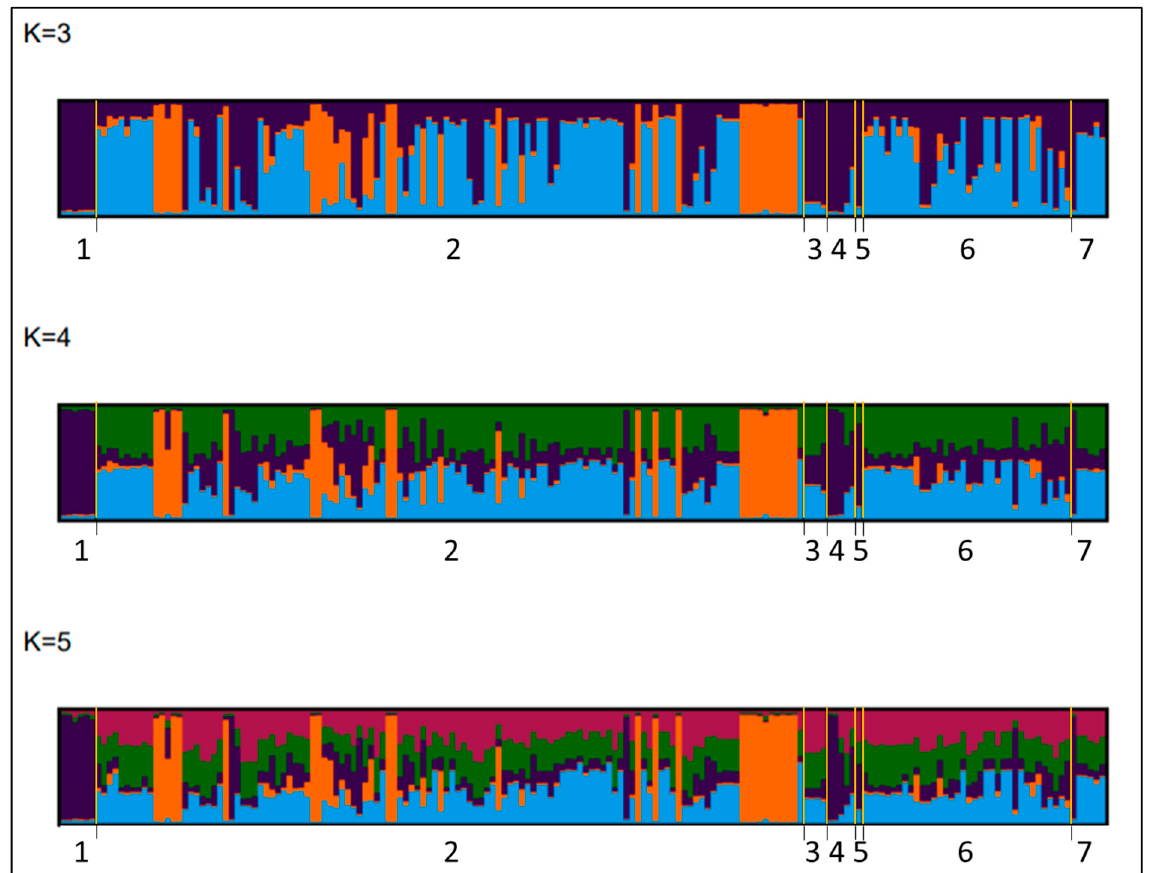
Figure 5. Samples from Boulder County, CO and a portion of California clustered apart from other sampled locations. Structure plots with K values 3–5. The amount of vertical color for each sample corresponds with the percentage of belonging to that color cluster. Admixture increased for plots using K = 4 and K = 5. Locations included in study were Boulder County, CO (1); California (2); Larimer County, CO (3); Massachusetts (4); New Jersey (5); New Mexico (6); and Weld County, CO (7).